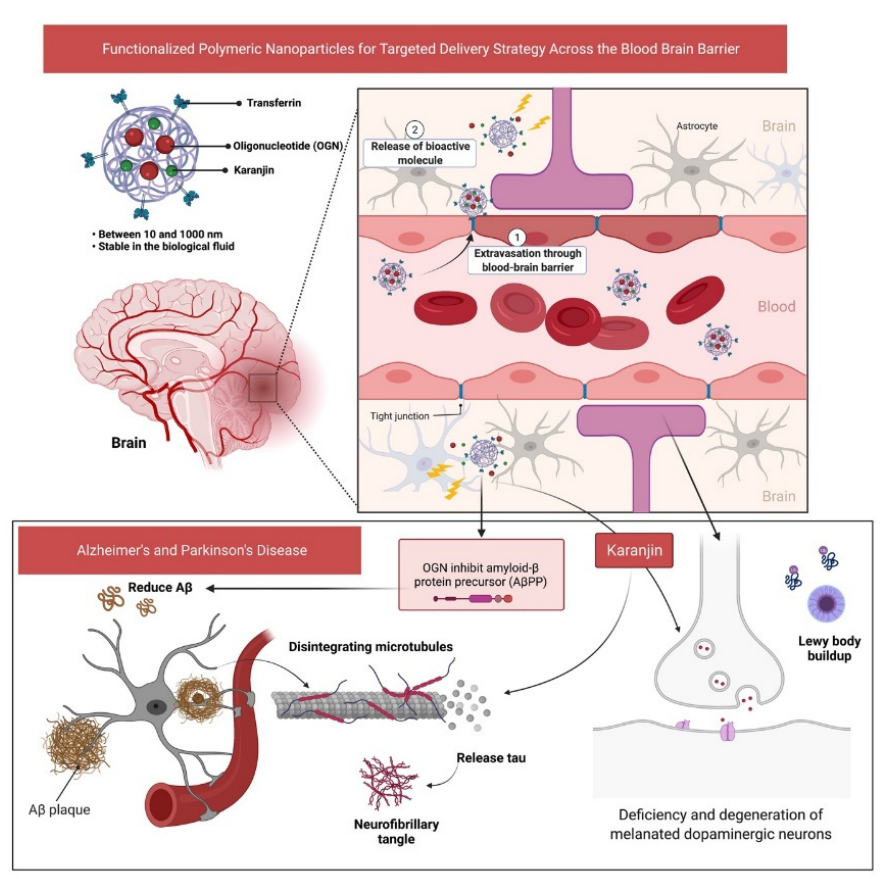
Figure 12. Schematic illustration of the proposed future perspective by employing surface modified polymeric nanoparticles loaded with oligonucleotides (OGN) and karanjin for enhanced delivery across the blood–brain barrier.